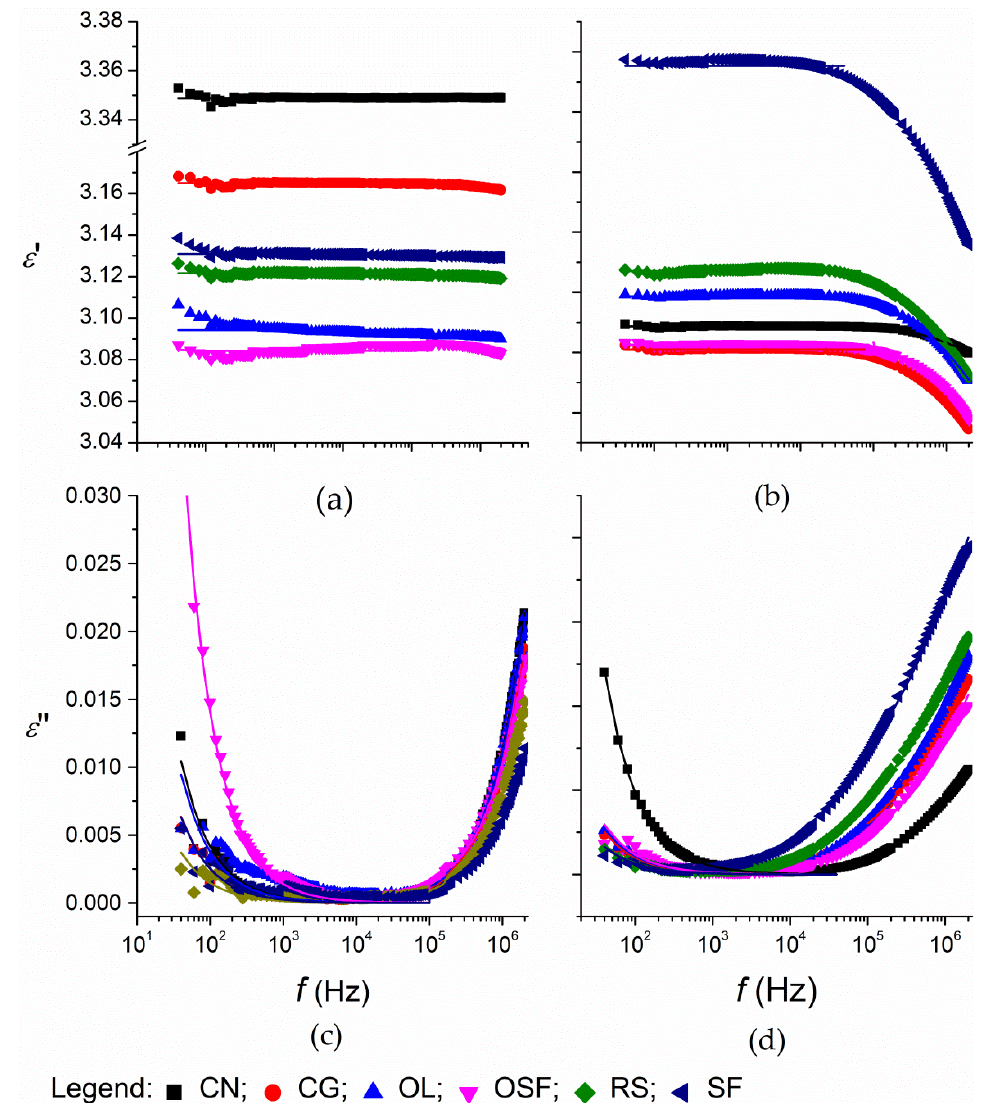
Figure 1. Dependence of the dielectric dispersion, ε ′ ( a , b ) and dielectric loss factor, ε ′′ ( c , d ) variations across the lowest ( a , c ) and highest ( b , d ) dispersion and loss on the frequency range from 40 Hz to 2 MHz, at 25 °C, for the edible oils thermally treated at 180 °C. Lines: fitted values according to Equations (4) and (6). CN, coconut oil; CG, corn-germ oil; OL, olive oil; RS, rapeseed oil; SF, sunflower oil; and OSF, high oleic acid sunflower.